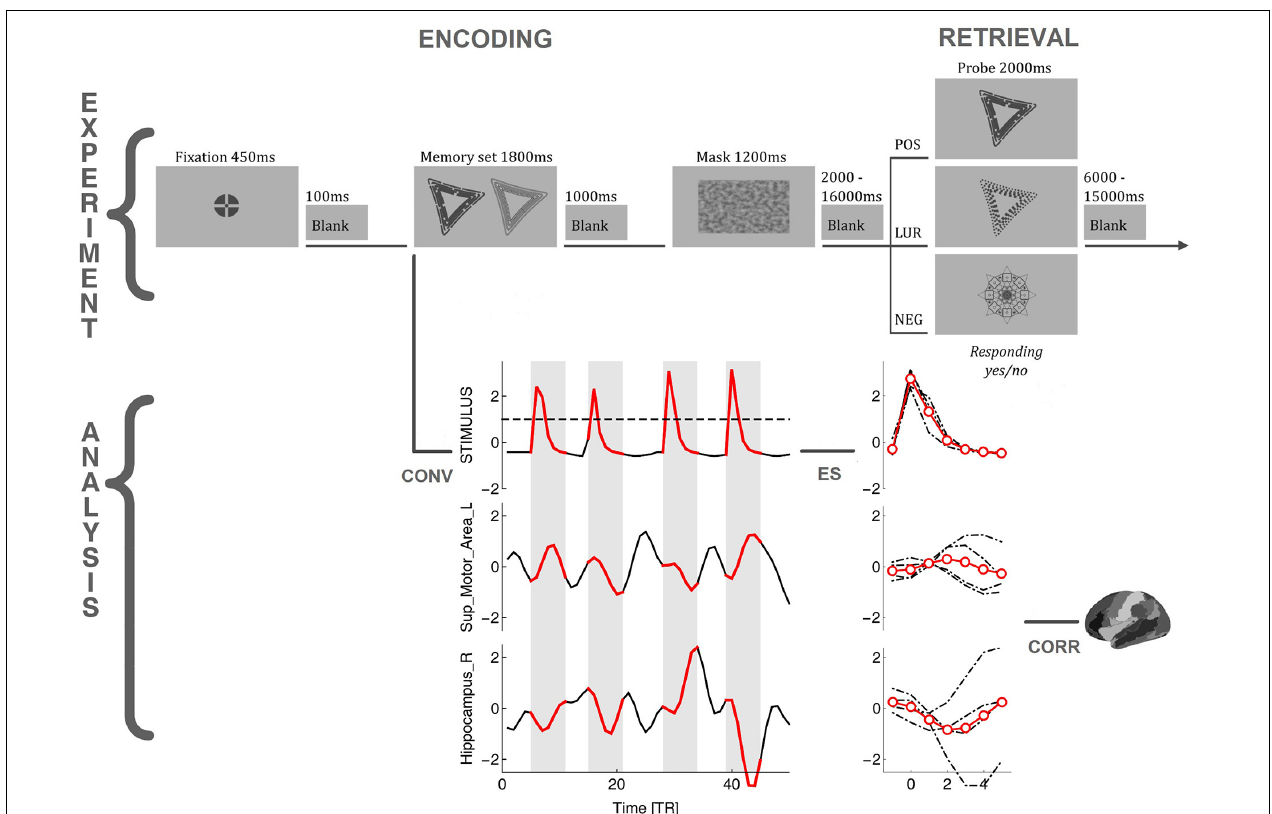
FIGURE 1 | The flowchart of the task requiring global information processing and analysis procedure. POS/LUR/NEG, positive, lure, and negative probes; CONV, convolution of the stimuli with a model hemodynamic response function; ES, identification, extraction, and averaging of BOLD events; CORR, correlating BOLD events with stimuli, Fisher transforming, and performing GLM